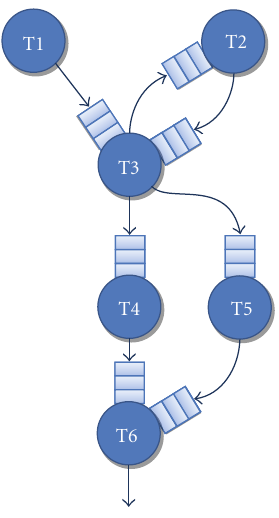
Figure 12: Proactive communication principle.